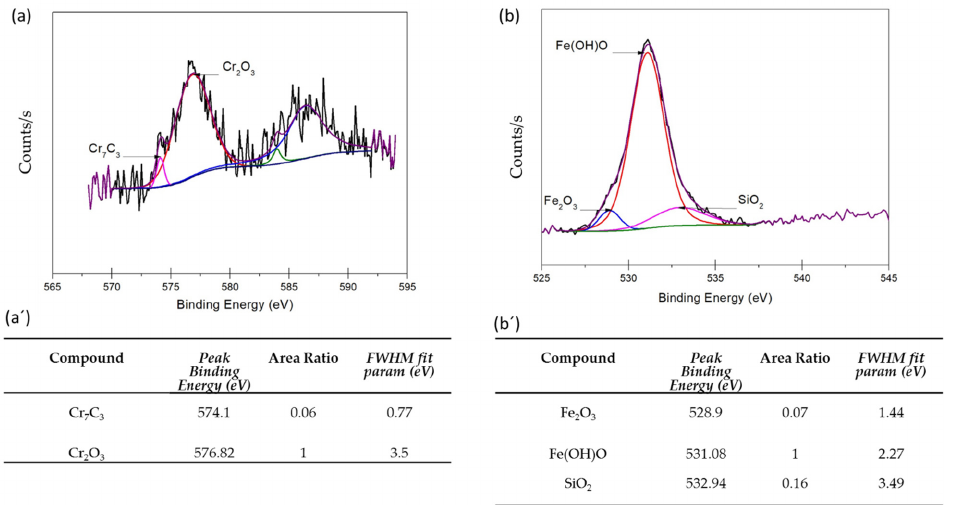
Figure 5. X-ray photoelectron spectra for AM350CA–50 min–49 °C: ( a ) Cr 2p, ( b ) O 1s. Parameters obtained: peak binding energy and FWHM fit param ( a’ ) Cr 2p, ( b’ ) O 1s.